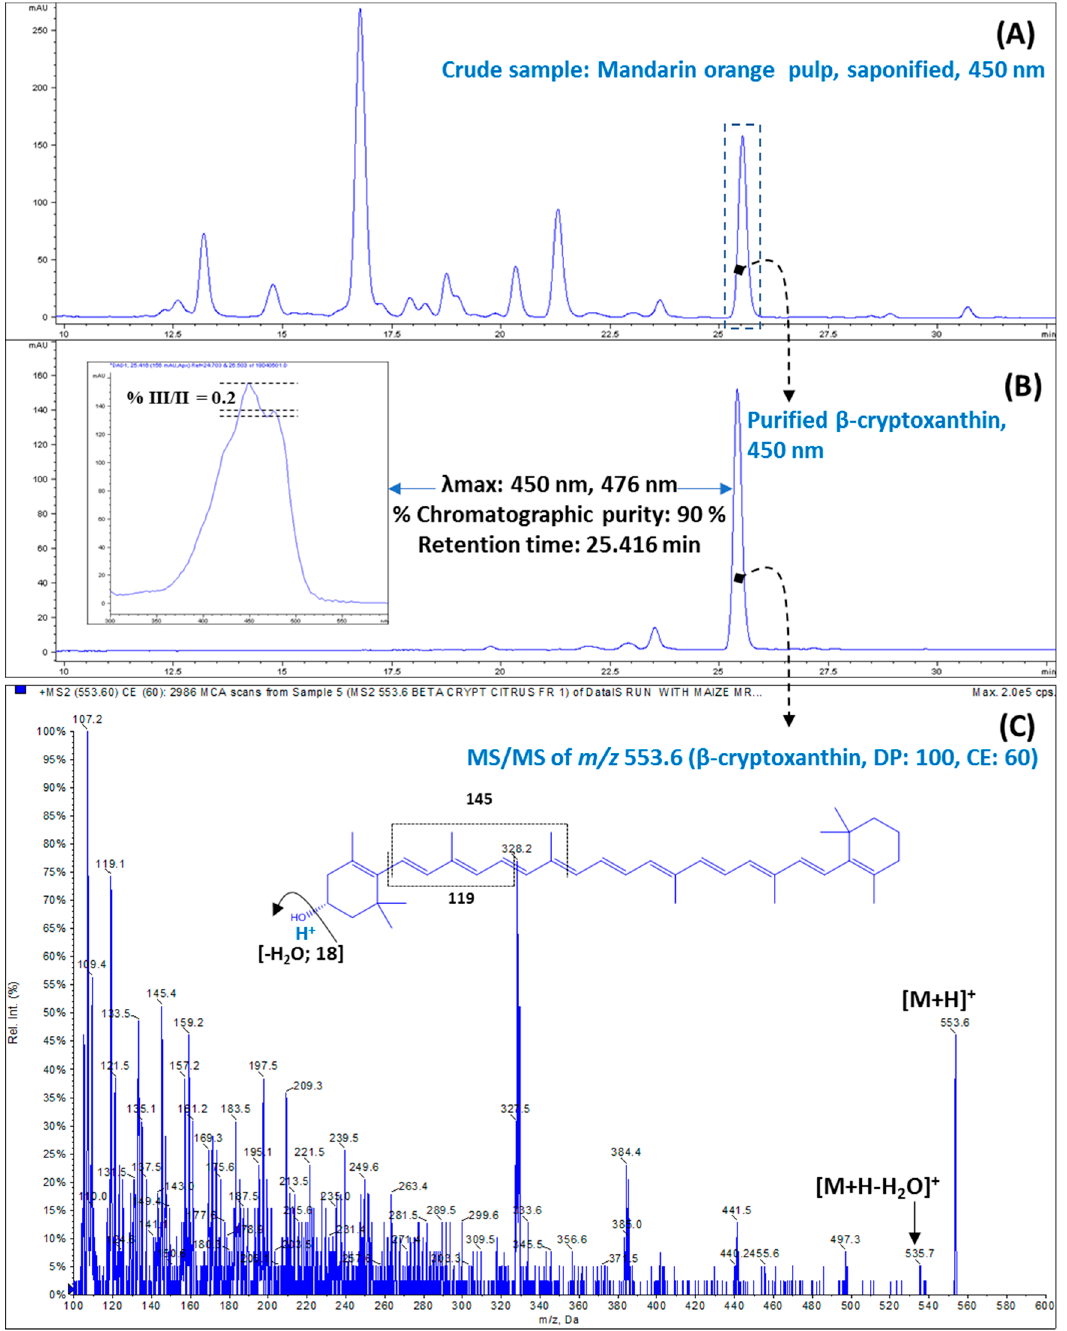
Isolation and characterization of β -cryptoxanthin. The high-performance liquid chromatography (HPLC) chromatogram of ( A ) a crude sample, and ( B ) isolated β -cryptoxanthin, showing λ max and spectral fine structure. ( C ) The fragmentation pattern (tandem mass spectrometry (MS2) of m / z 553.6) of the β -cryptoxanthin molecule recorded using atmospheric-pressure chemical ionization (APCI) +